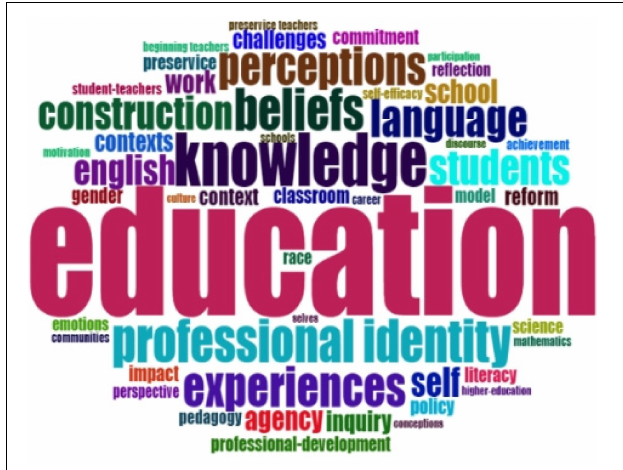
FIGURE 5 | Word Cloud by author’s keywords’ plus.